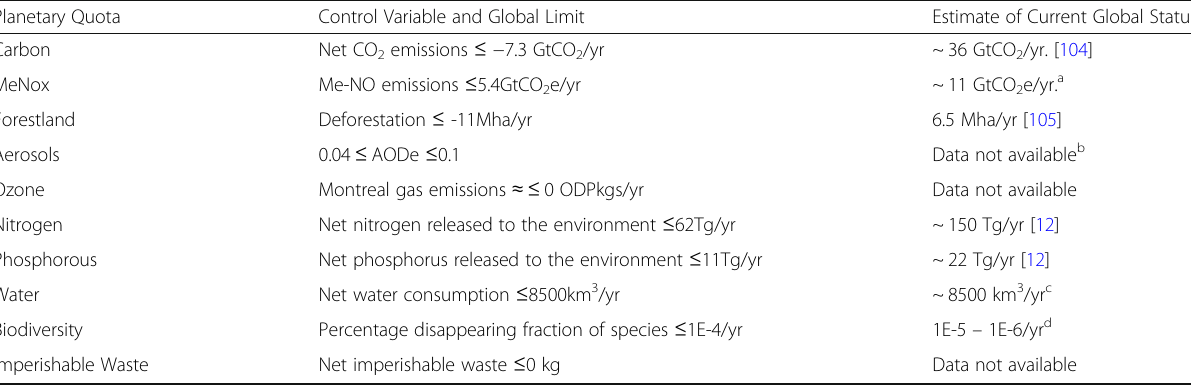
Table 5 Each of the Planetary Quotas is shown against the estimate current global